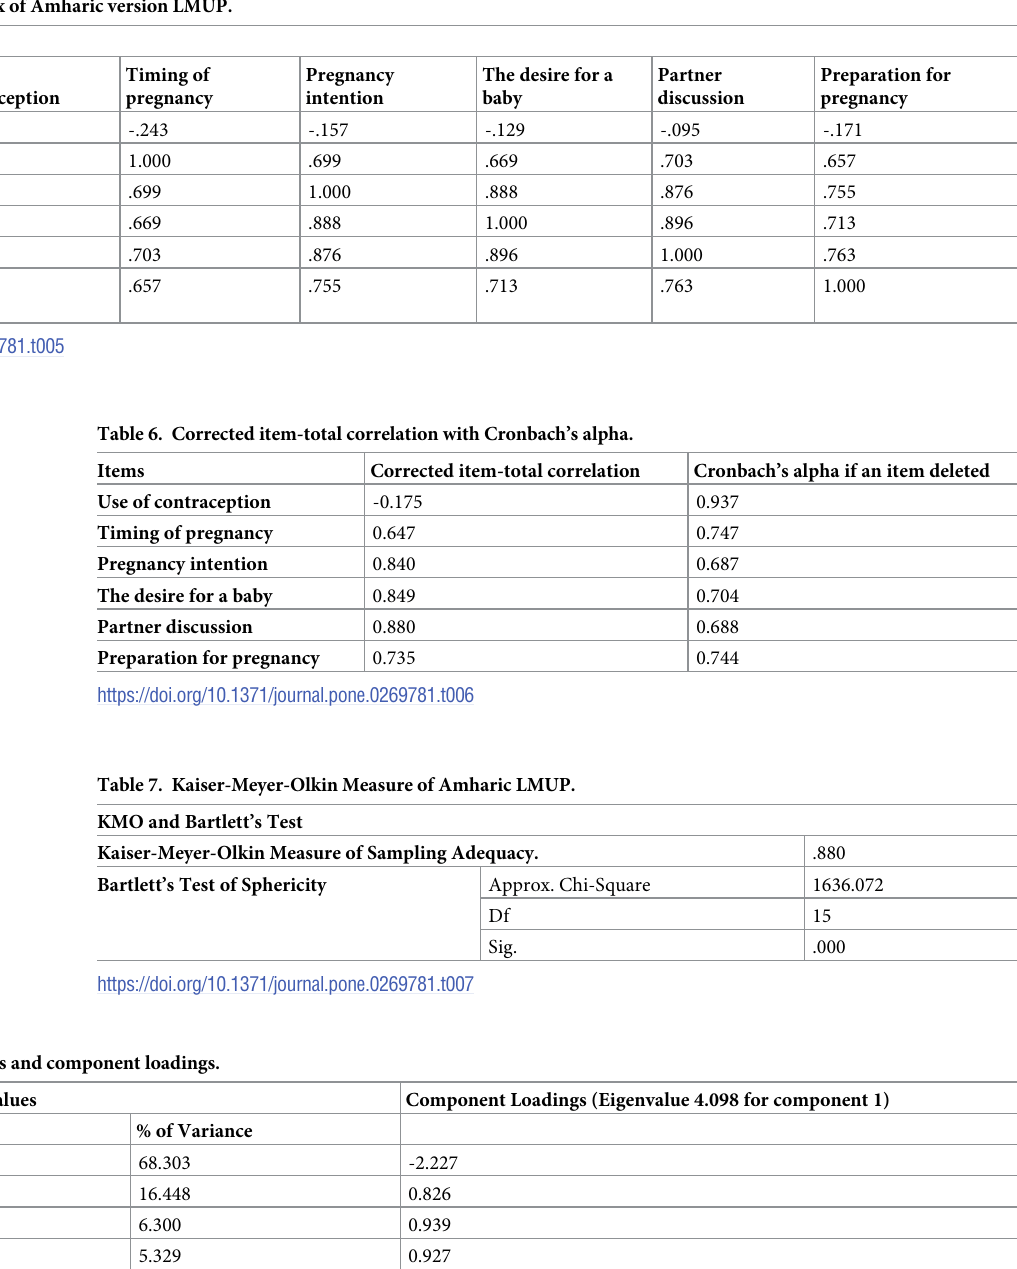
Table 5. Inter-item correlation matrix of Amharic version LMUP.